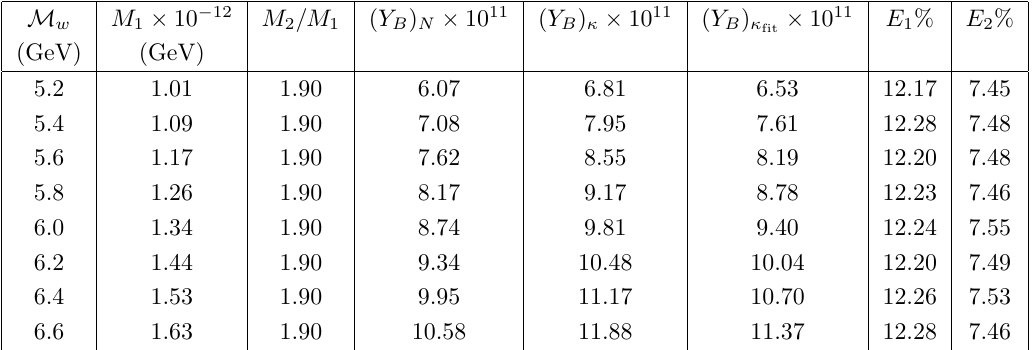
Table 3 . Comparison between the (cid:12)nal baryon asymmetry evaluated by direct numerical so- lution of Boltzmann equation (denoted by ( Y B ) N in the table) with that calculated using ana- lytic formulas, (cid:20) f and (cid:20) (cid:12)t (corresponding baryon asymmetry parameters are denoted by ( Y B ) (cid:20) and i ( Y B ) (cid:20) respectively). E 1 and E 2 are percentage errors given by E 1 % = fit (cid:12) (cid:12) ( Y B ) (cid:20) (cid:0) ( Y B ) N (cid:12) (cid:12) E 2 % = (cid:2) 100. fit (cid:12) (cid:12) ( Y B ) N